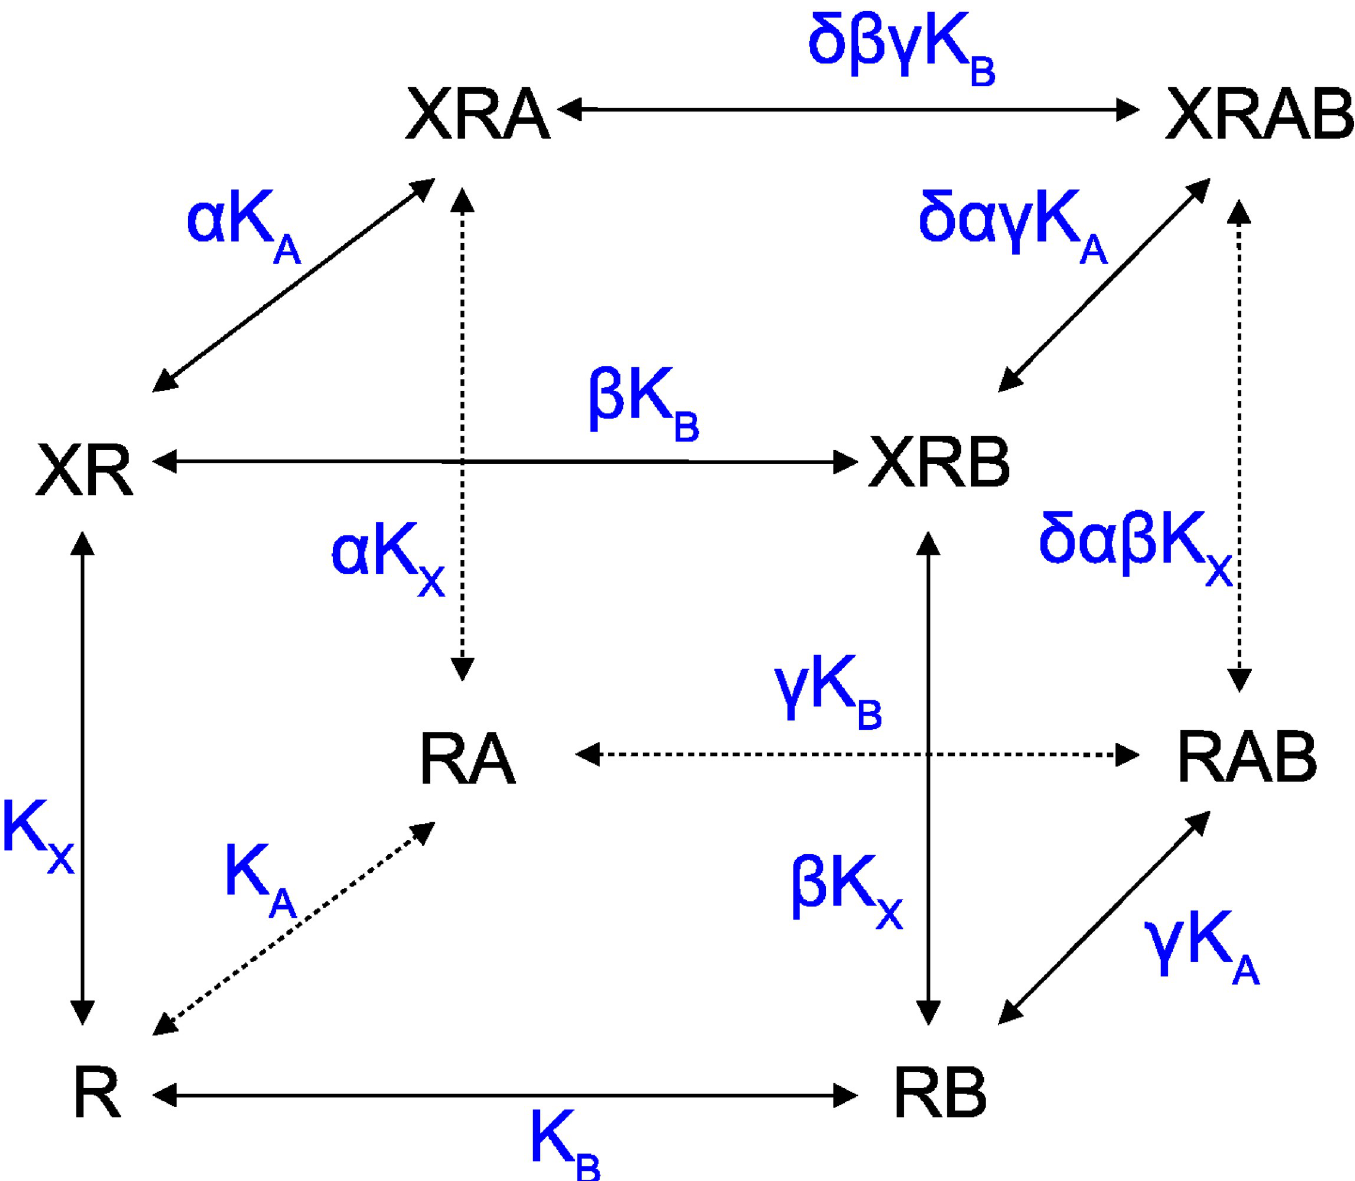
Fig 3. Two allosteric modulators each binding to its own site. Allosteric interaction between tracer X and allosteric modulators A and B at receptor R. Each allosteric modulator binds to its own site, with cooperative interaction between the two sites. Besides parameters listed in Figs 1 and 2 , γ is the factor of binding cooperativity between modulator A and modulator B and δ is the change in factor cooperativity γ caused by tracer